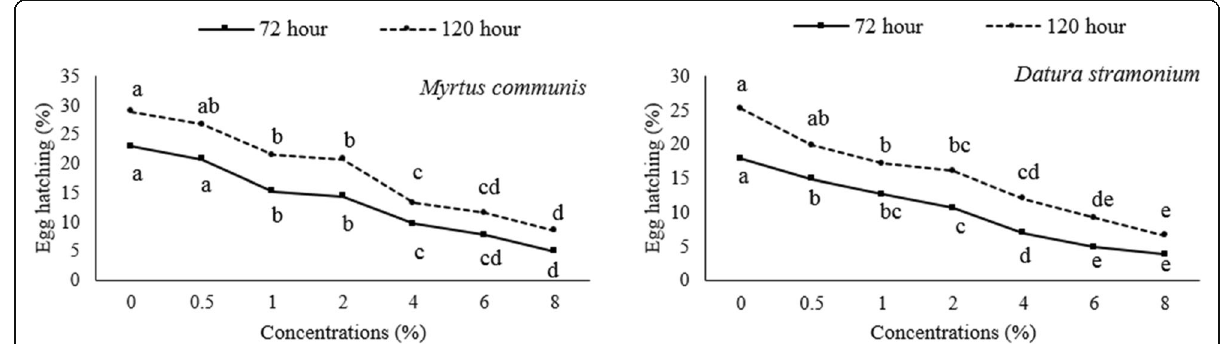
Fig. 2 Mean egg hatching of Meloidogyne javanica 72 and 120 h after different concentrations of Datura stramonium and Myrtus communis treatments. Means are average of four replications. Means followed by the same letter(s) are not different according to LSDs ( p ≤